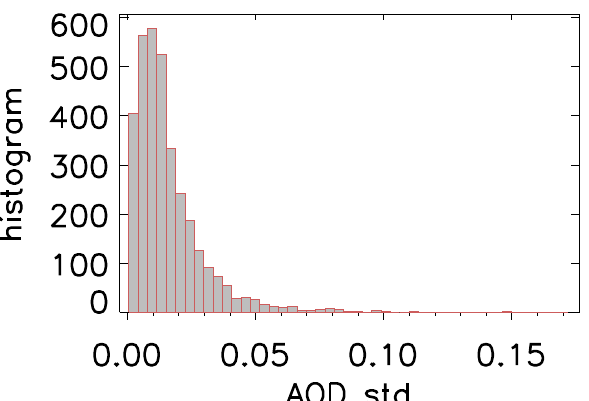
Fig. 11. Sensitivity of AOD retrieval to the errors in daily average AOD. The geometry is set for GOES-East at Railroad Valley on day 213 at 22:00UTC with surface reflectance assumed to be